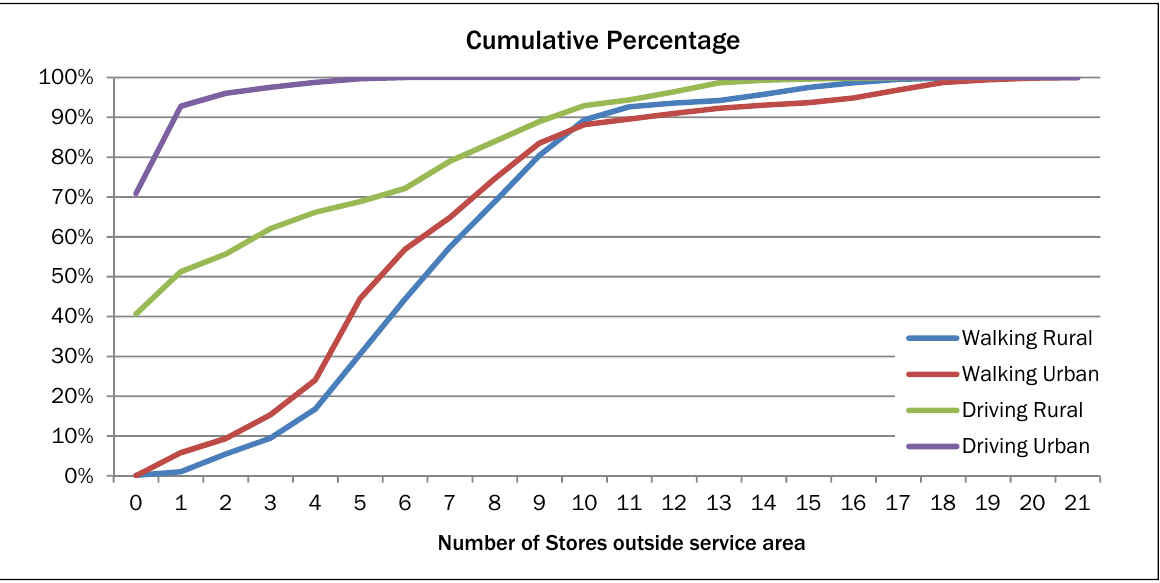
Figure 8. Percentage of residential parcels from which a shopper would have to visit up to a given number of stores that are outside of an assumed service area to acquire all items in the USDA Thrifty Food Plan at the lowest